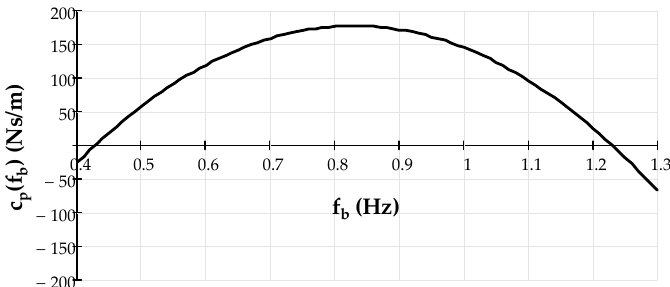
Figure 4. The damping coe ffi cient cp(fb) independent of the pedestrian step frequency f p obtained through Equation (5).